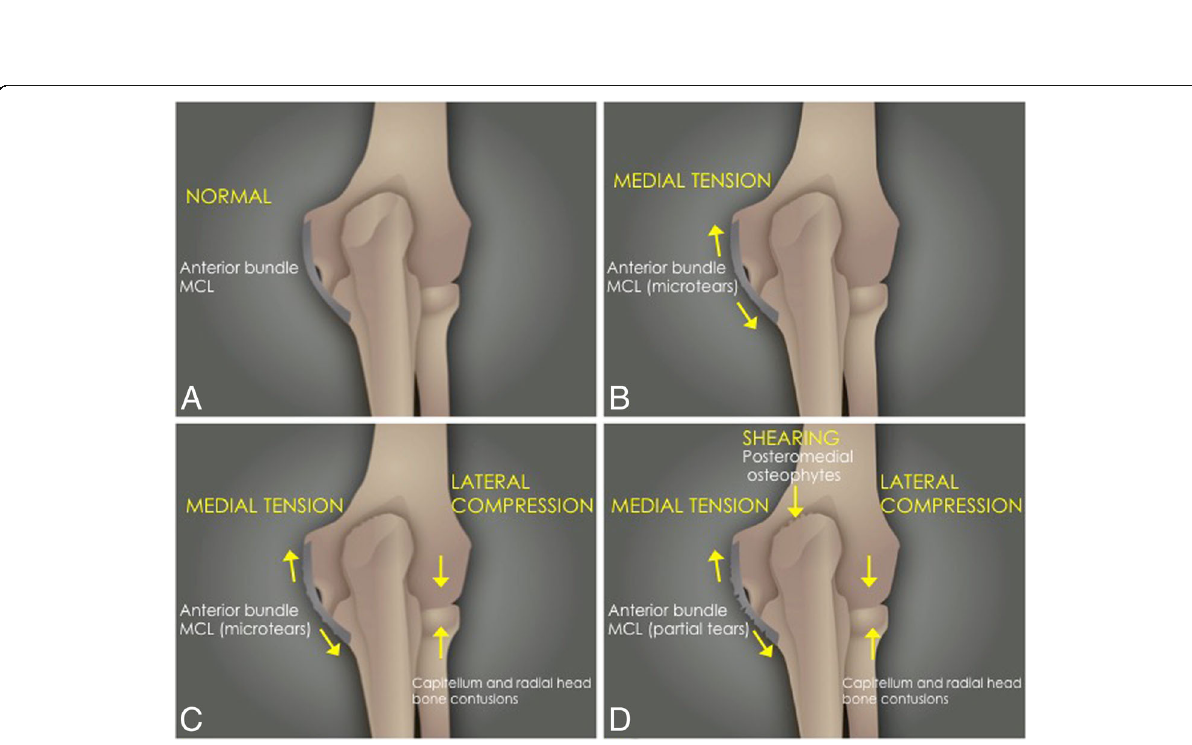
Fig. 13 Posterior coronal view ( a – d ) of the elbow showing the mechanism of injury in the overhead athlete with repeated valgus